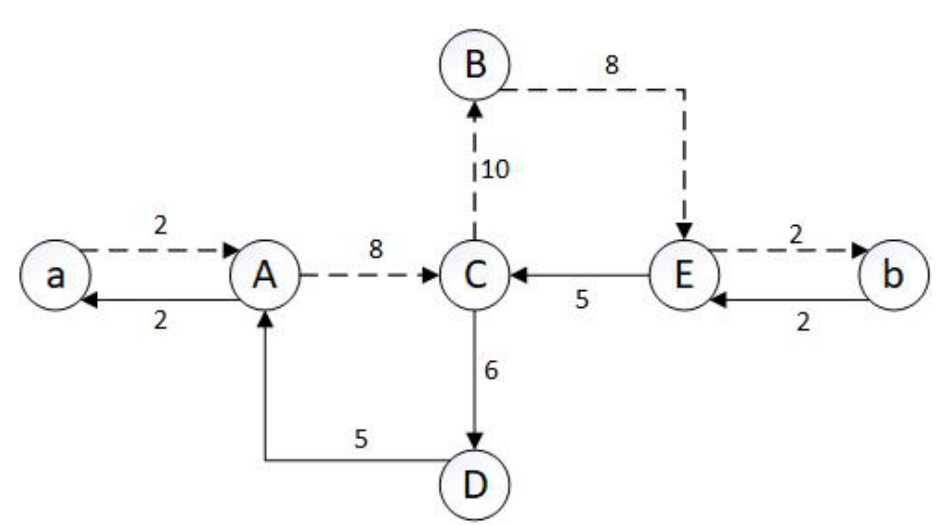
Figure 1. Example of a small network with running times (based on